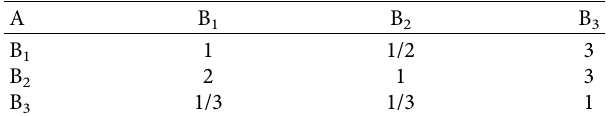
Figure 10: AHP model for distributing the working face in the protected seam for pressure relief by peak shift. Table 2: The judgment matrix of the conditional layers B relative to the target layer